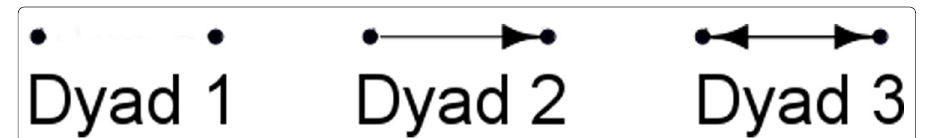
Fig. 1 Dyadic Subgraphs. All nonisomorphic directed graphs consisting of two vertices. Dyad 3 represents recurrent connections which are thought to be important in information storage and processing in neural circuits